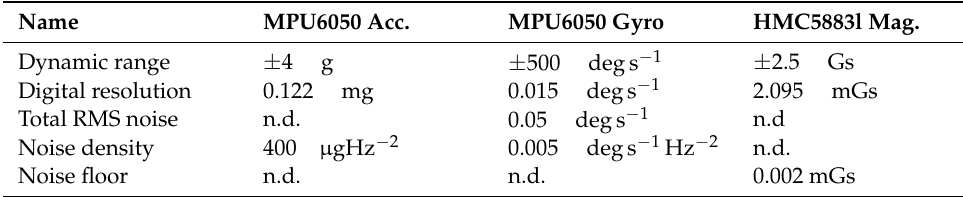
Figure 1. Architecture of the proposed duplex IMU. On top, the Raspberry Pi 3B platform, running the SFDI algorithm and data logging. Below, Flip32-based IMU boards, with MPU6050 and HMC5883L MEMS sensors. Table 1. MEMS sensor characteristics from